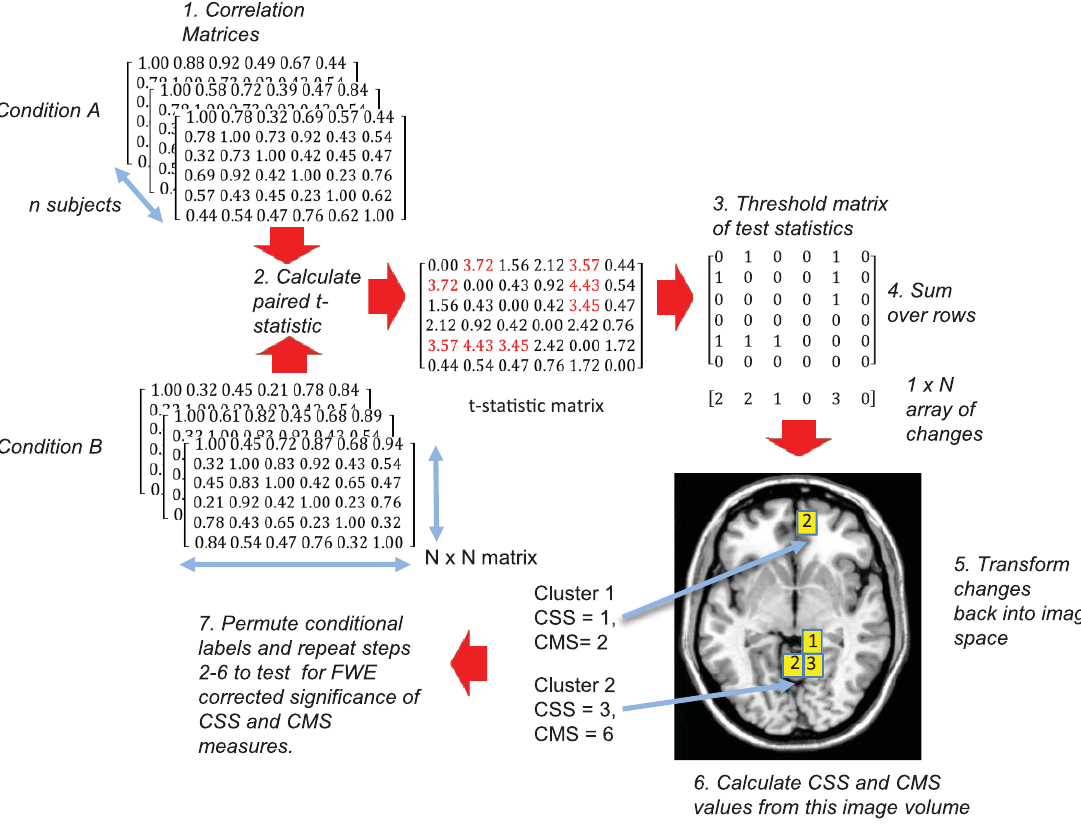
Figure 2. CMS/CSS methods. Illustration of data processing workflow for CSS and CMS measures. Note: The matrices are limited in size and only contain positive values for ease of exposition.